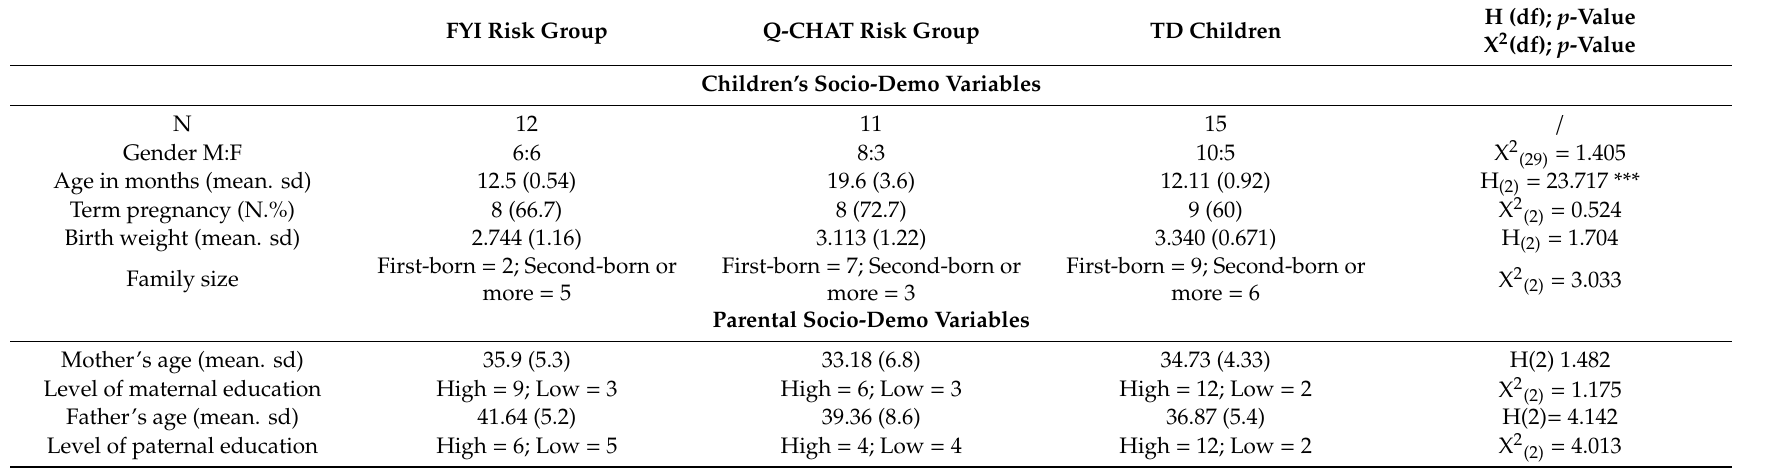
Table 2. Comparison between risk groups and typically developing children who agreed to the psychological